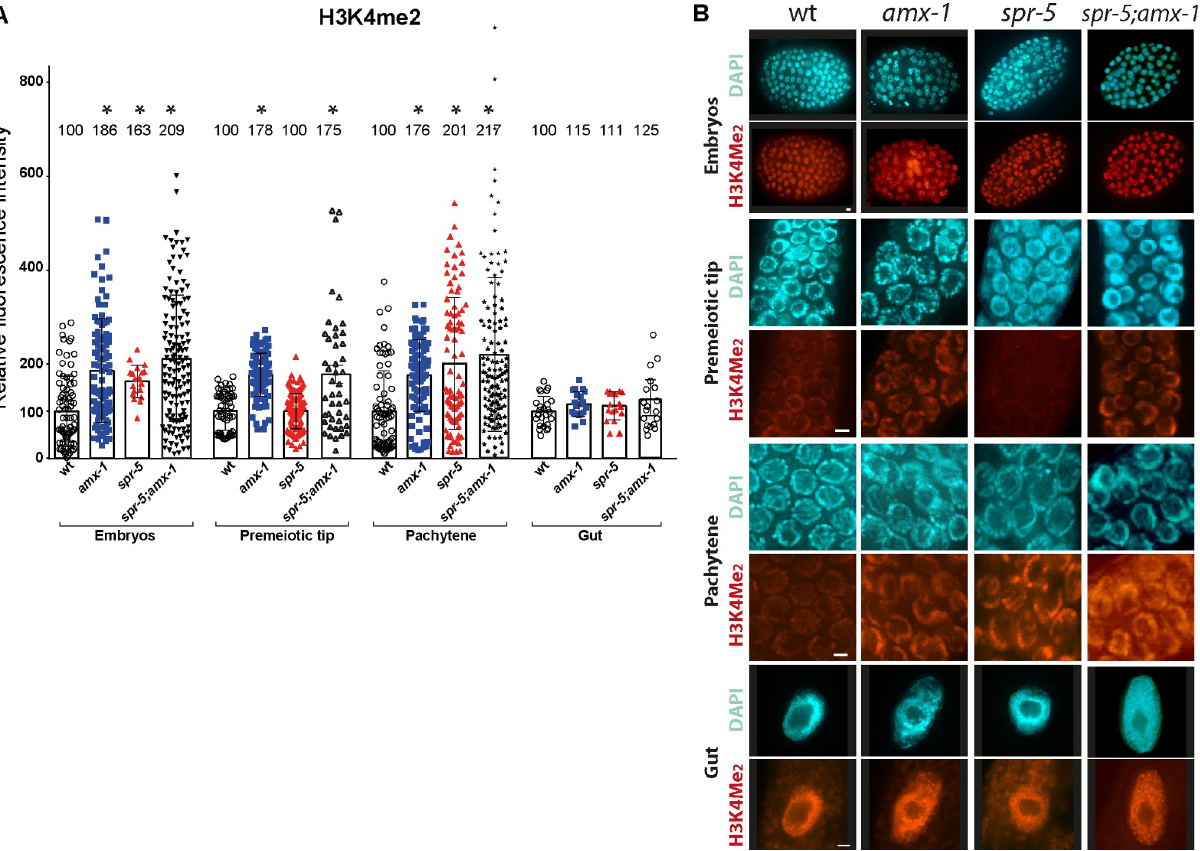
Fig 4. Lack of AMX-1 expression results in a significant increase in H3K4me2 level in both embryos and germlines. (A) H3K4me2 signal intensity was significantly increased in nuclei in embryonic cells (~1.8-fold), premeiotic tip (~1.8-fold), and pachytene (~1.8-fold) compared to wild type (P < 0.0001 for all three comparisons). No significant induction was detected in gut nuclei (P = 0.0847 for amx-1 and wt). spr-5;amx-1 double mutants did not display additive or synergistic effects on histone methylation levels compared to amx-1 single mutants (in PMT, P = 0.1461; in embryo, P = 0.3080; in pachytene, P = 0.6434; in gut cells, P = 0.7680 for amx-1 and spr-5;amx-1 ). Individual nuclei were sampled for fluorescence intensity using ImageJ. The bars represent the mean fluorescence intensity. N = 5–8 gonads. (B) Representative images used for the analysis. Bars, 2 μ m. Wider field images are available in S10